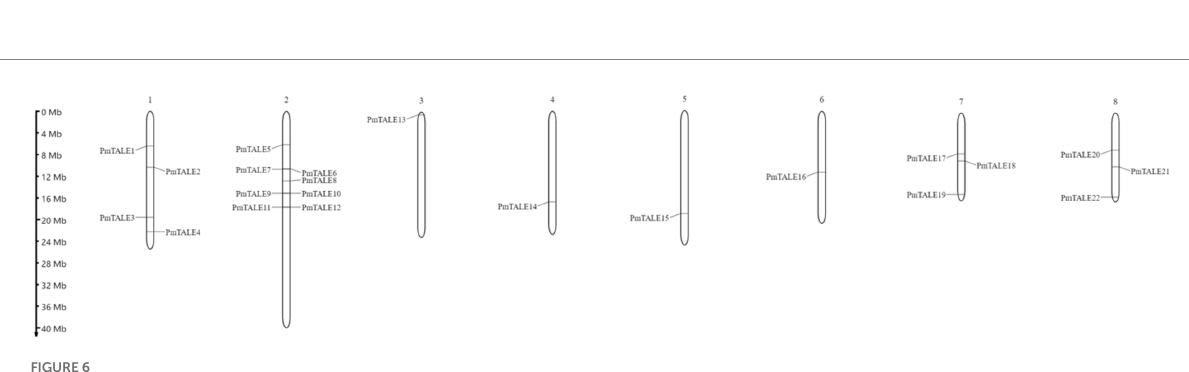
FIGURE 6 Chromosomal location of the Prunus mume TALE gene family.